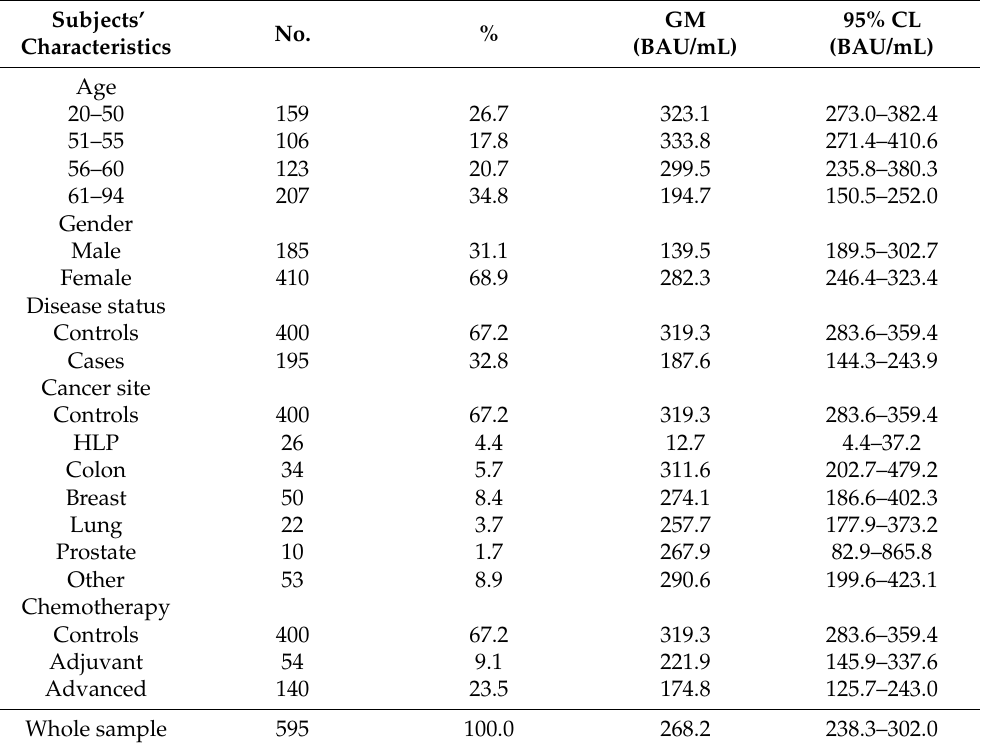
Table 2. Antibody levels after two doses of